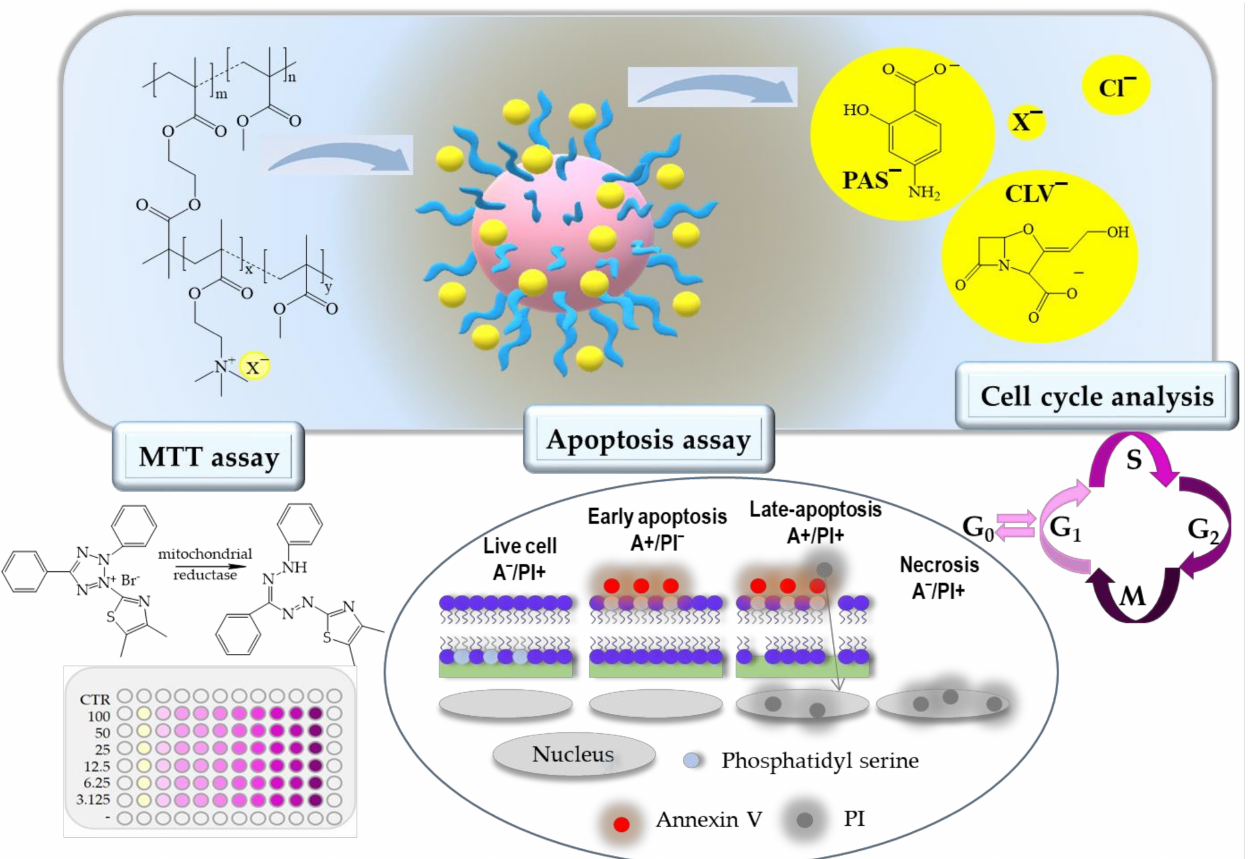
Figure 1. PIL and their conjugates with pharmaceutical anions for cytotoxicity evaluation. Table 1. Characteristics of amphiphilic graft copolymers and conjugates with PAS − and CLV − a .